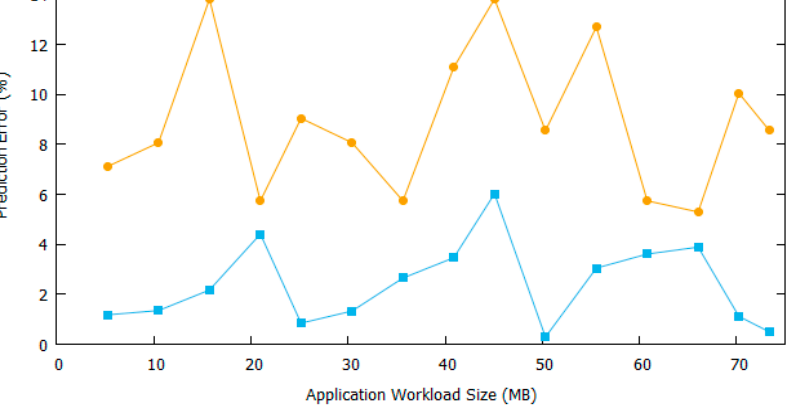
Figure 8. Prediction error graph.